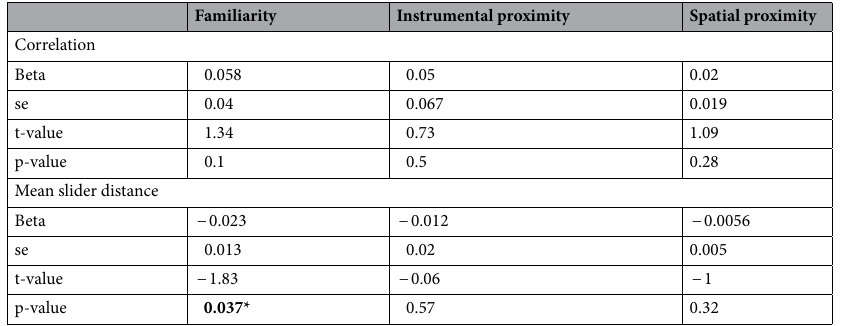
Table 1. Associations between coordination at the level of intentions and relational factors. We report the output of linear mixed regressions assessing the impact of pairs of musician’s familiarities, and spatial and instrumental proximities on the correlation and mean distance of their ratings on the sliders. Significant effects are highlighted in bold. None of these regressions were significant for musical actions (all p-values >